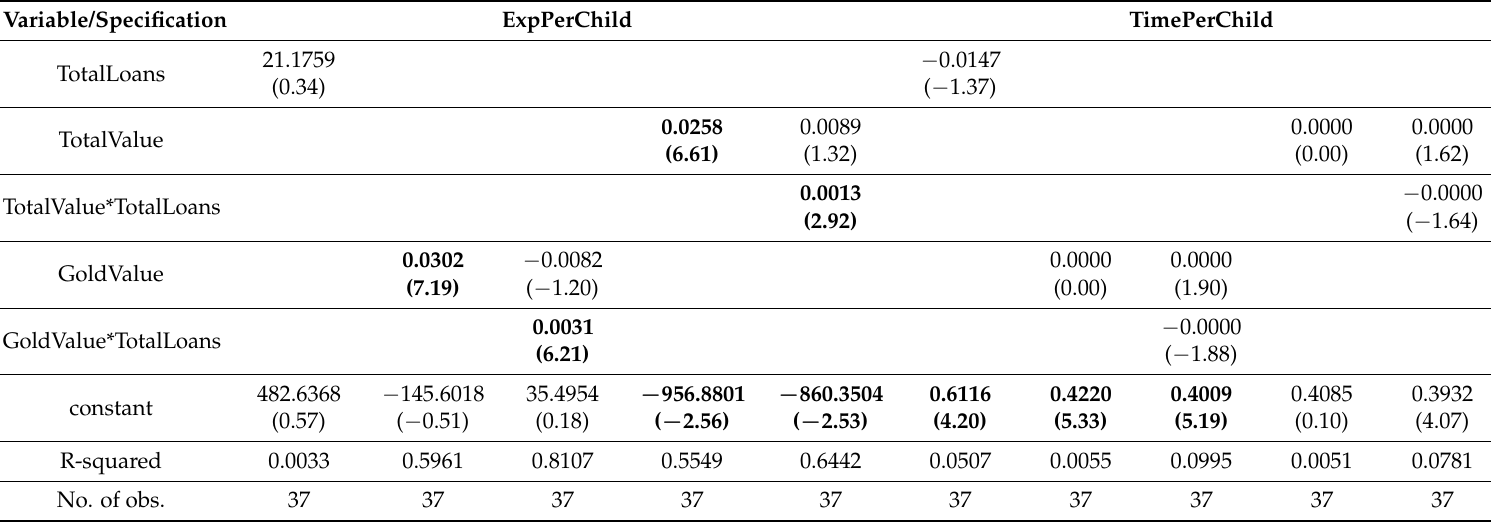
Table 3. Educational Investment and